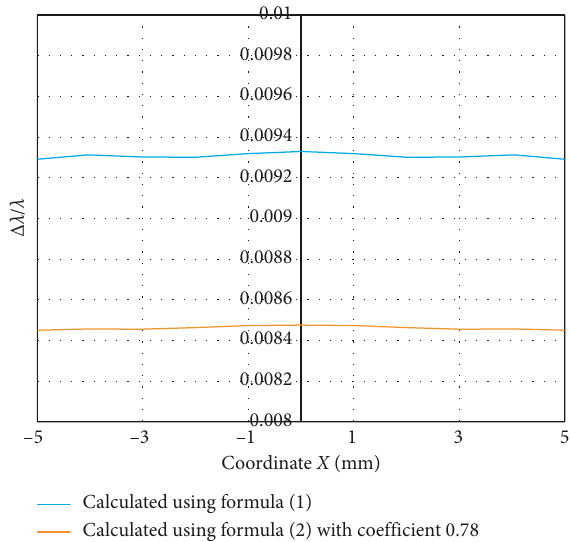
λ / λ when the fiber is attached to the Δ